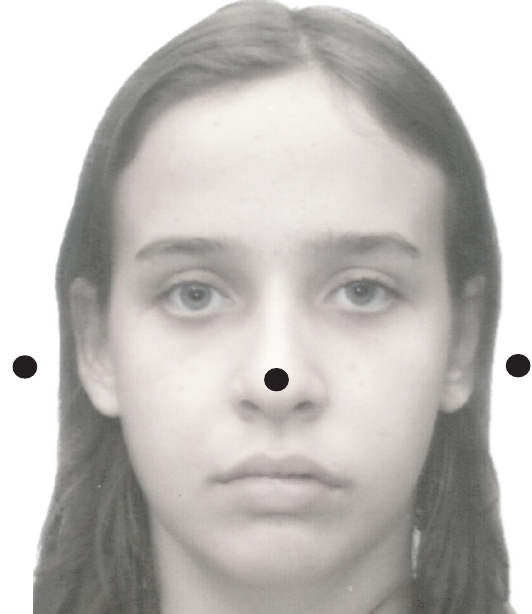
Figura 1. Exemplo de face-estímulo para investigação do fenômeno de muitas-faces no ponto cego. Para ver o fenômeno, feche o olho direito e focalize o ponto preto à direita da imagem. Varie a distância (no máximo a 30cm) e pare quando o ponto do nariz desaparecer. Mantenha a fixação e veja o efeito. Faça o oposto para observar com o olho